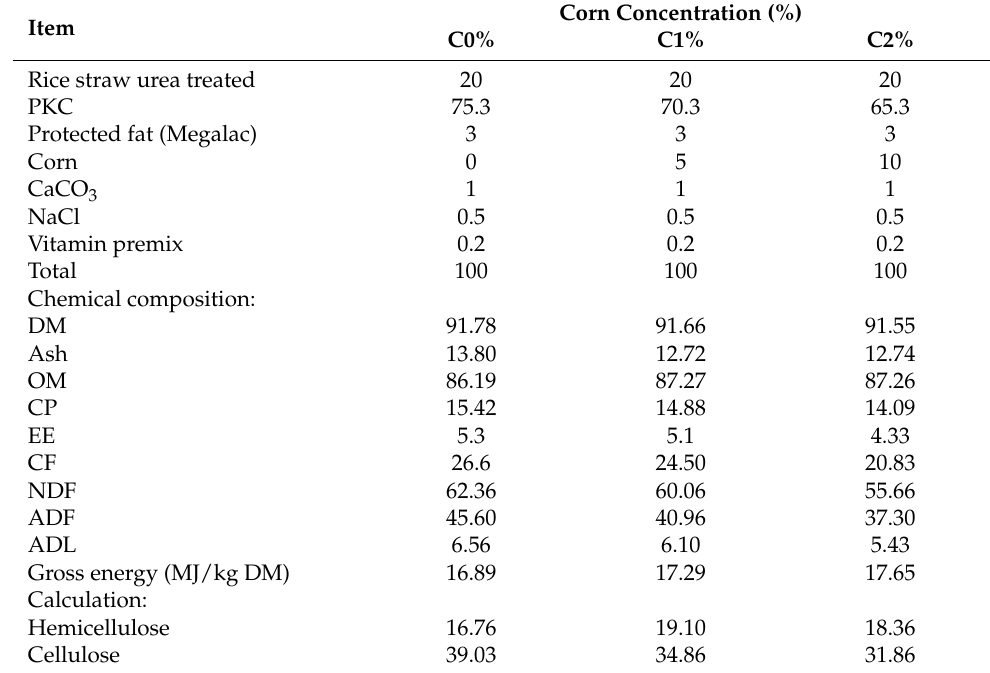
Table 1. Ingredients and chemical compositions of the treatment diets (DM